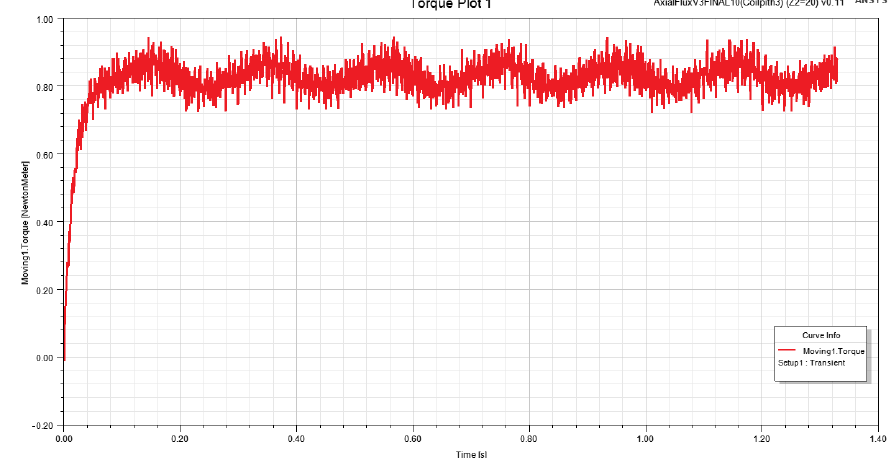
Figure 6. Electromagnetic torque.